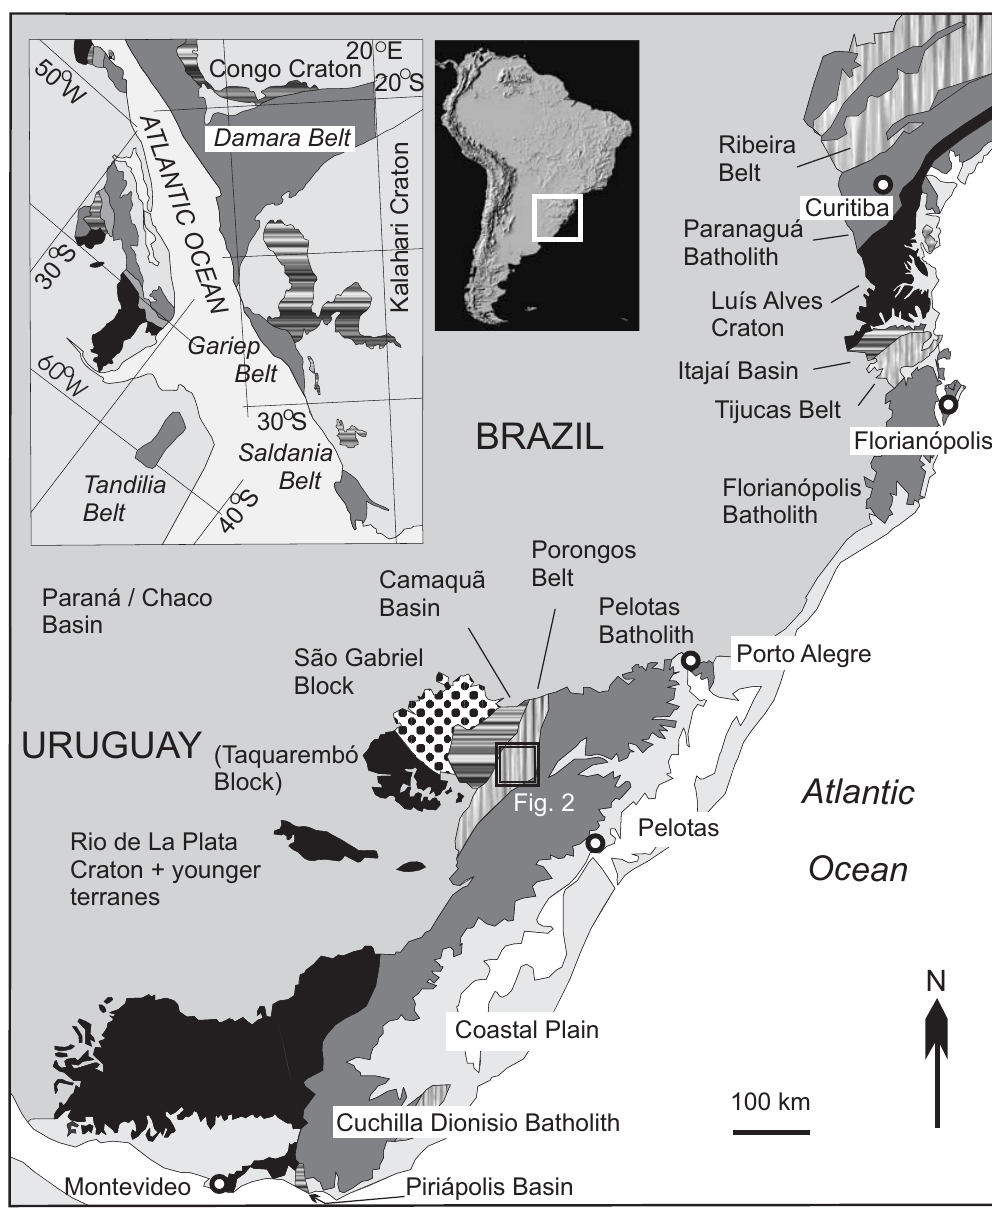
Fig. 1 – Geological map of southern Brazil, showing location in South America and correlation with southern Africa. Location of Figure 2